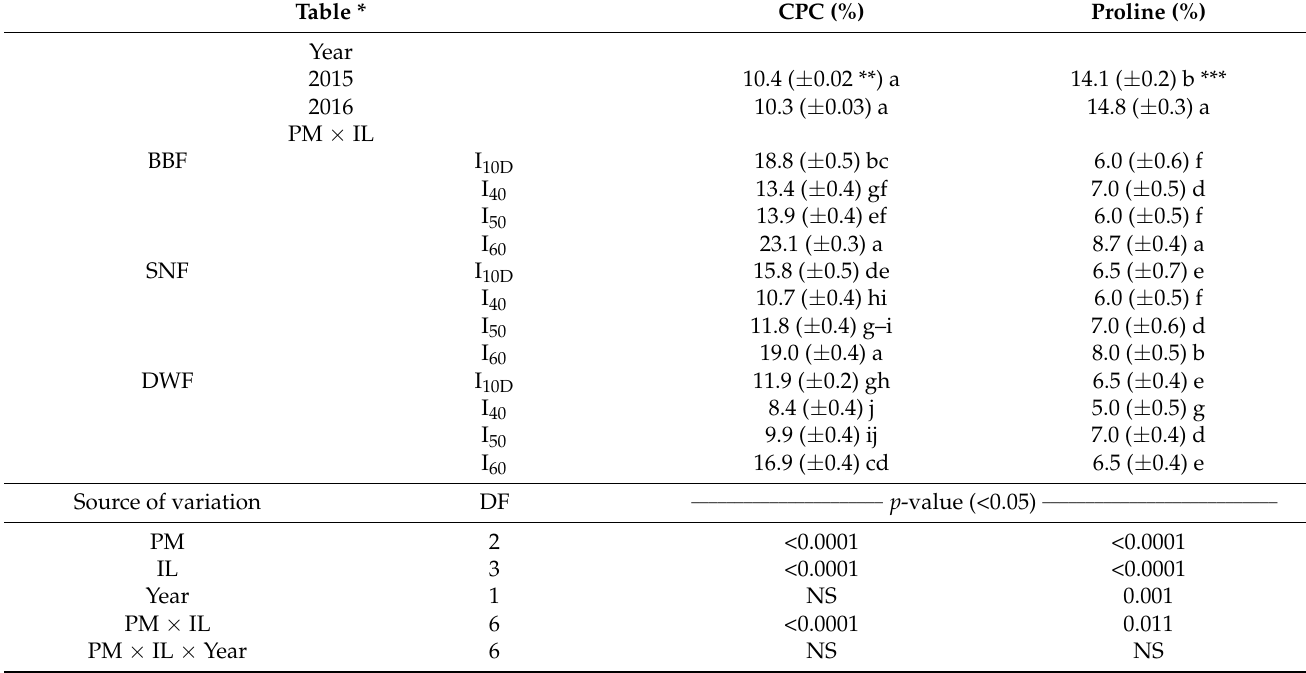
Table 5. Effect of planting methods, irrigation levels and year on crude protein content (CPC) and proline content of maize at Dharwad,